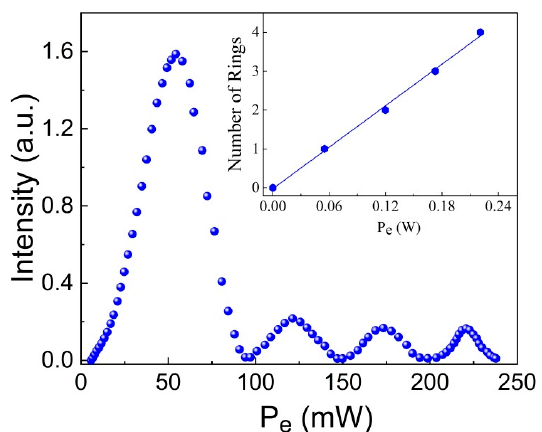
Figure 4. The number of rings (N) as a function of excitation beam power ( P e ) for pigment that was extracted from the plant in aqueous solutions ( α = 3.3 cm − 1 , pH 5.2, and λ = 514.5 nm). Inset: N ver-